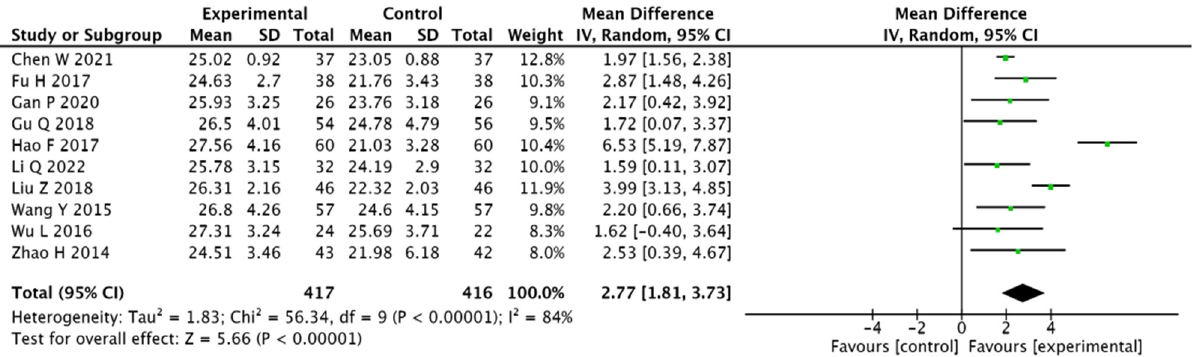
Figure 6. Forest plot of MMSE scores. 3.3.4. Chinese Medicine Symptom Score A total of 320 patients included in 5 publications [13,17,20,26,28] used the TCM symp- tom score as an evaluation index. The results present homogeneity among the 4 included publications and were therefore analysed using a fixed-effects model (I2 = 25%, [MD = − 1.84, 95% CI ( − 2.58, − 1.10), p < 0.0001]). This suggests that adjuvant Chinese medicine improves the TCM symptom score of T2DM combined with MCI more effectively than conventional Western medicine (see Figure 7).